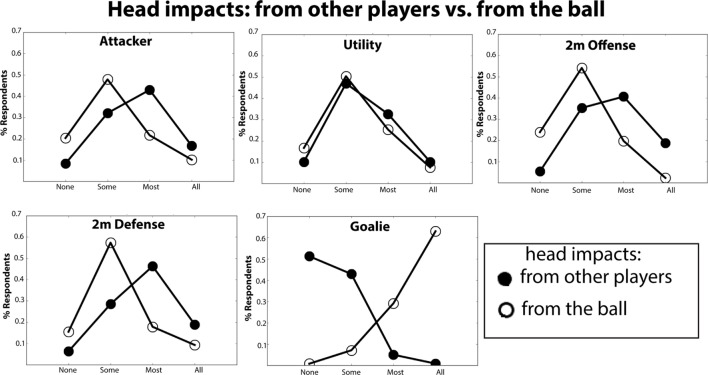
Histogram of reported prevalence of head impacts caused by other players vs. the ball. On the y-axis is plotted the % of respondents that indicated that their heads’ were struck: none, some, most, or all of time by other players (closed circles) or by the ball (open circle).